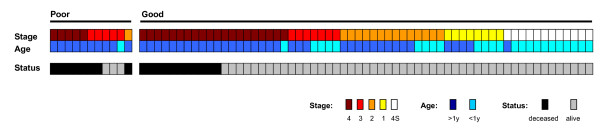
Risk factors and survival of 72 MYCN not amplified patients. Patients are divided in poor and good prognosis groups according to the NB-hypo. Columns represent individual patients. The first line represents the patients according to the International Neuroblastoma Staging System (INSS). The second line represents the patients according to the age at diagnosis (> 1 year vs. < 1 year). In the last line, the patients are divided in deceased, black squares, and alive, gray squares.